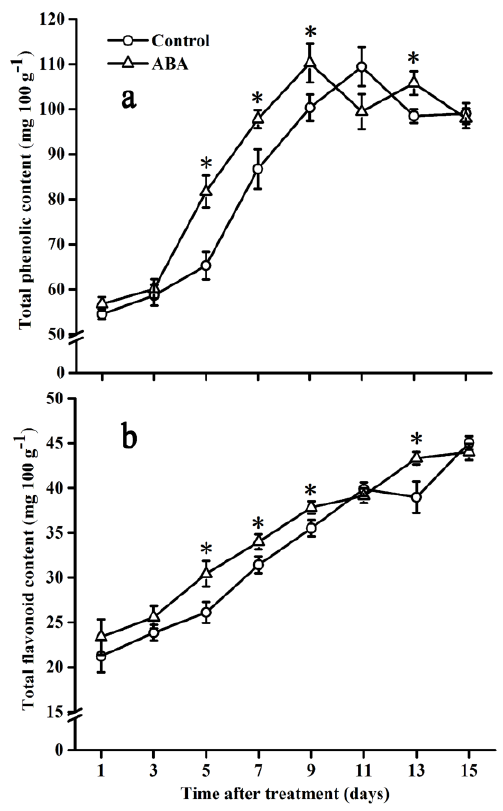
Figure 2. Effect of ABA on the total phenolic ( a ) and flavonoid ( b ) content in the tomato during storage at 20 °C. Vertical bars represent the standard deviation (SD, n = 3). Asterisks (*) represent significant differences ( p < 0.05) between the ABA and control treatments.